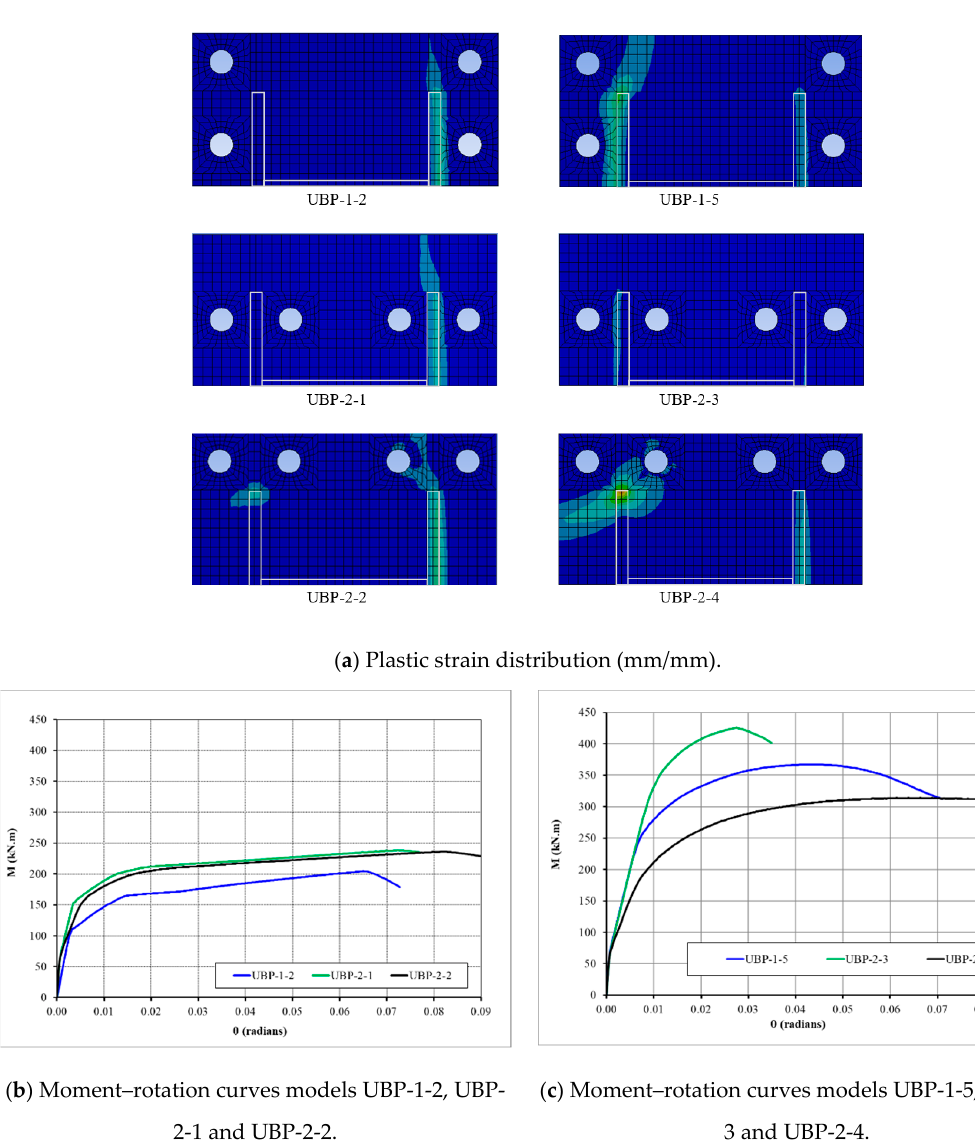
Figure 6. Influence of the anchor rods configuration.